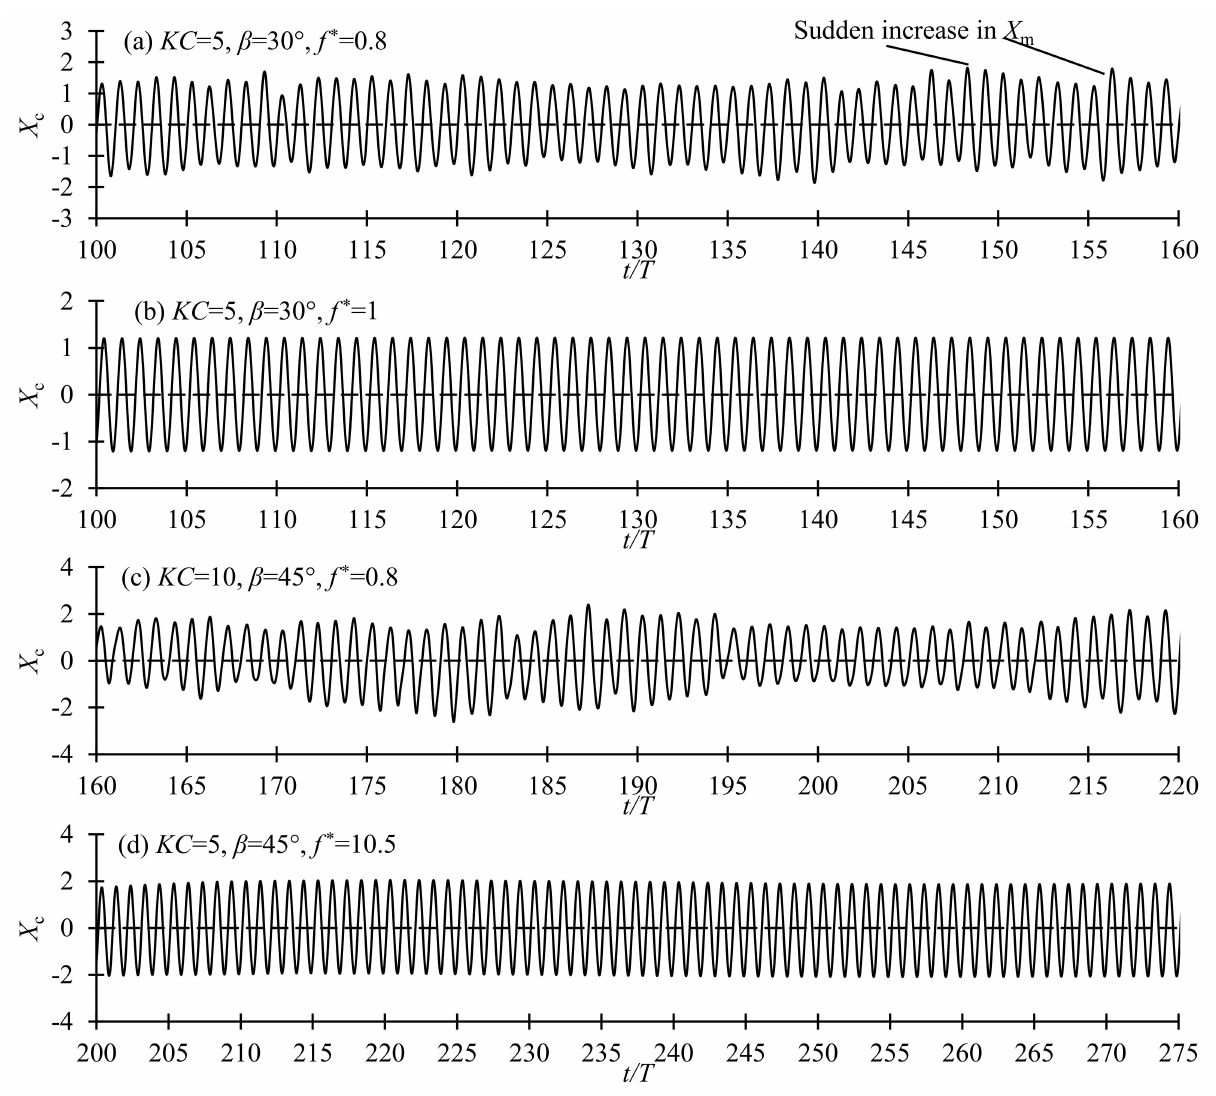
Figure 14. Time histories of the vibration